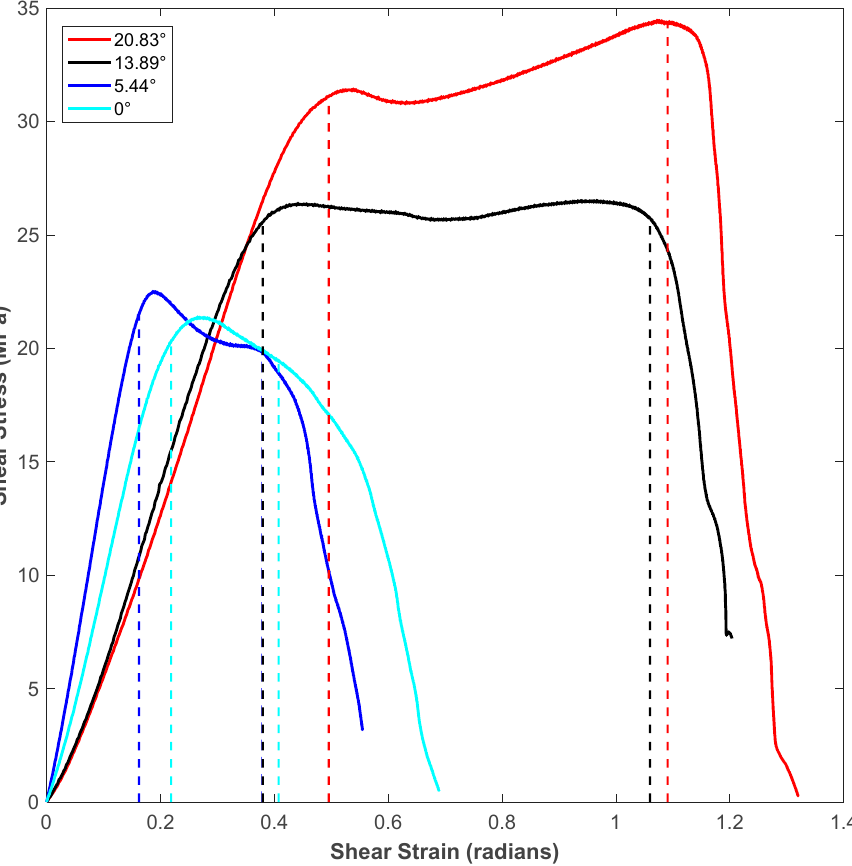
Figure 9. Shear stress-strain response for the +45°/ − 45° raster orientation with all four notch angle configurations.